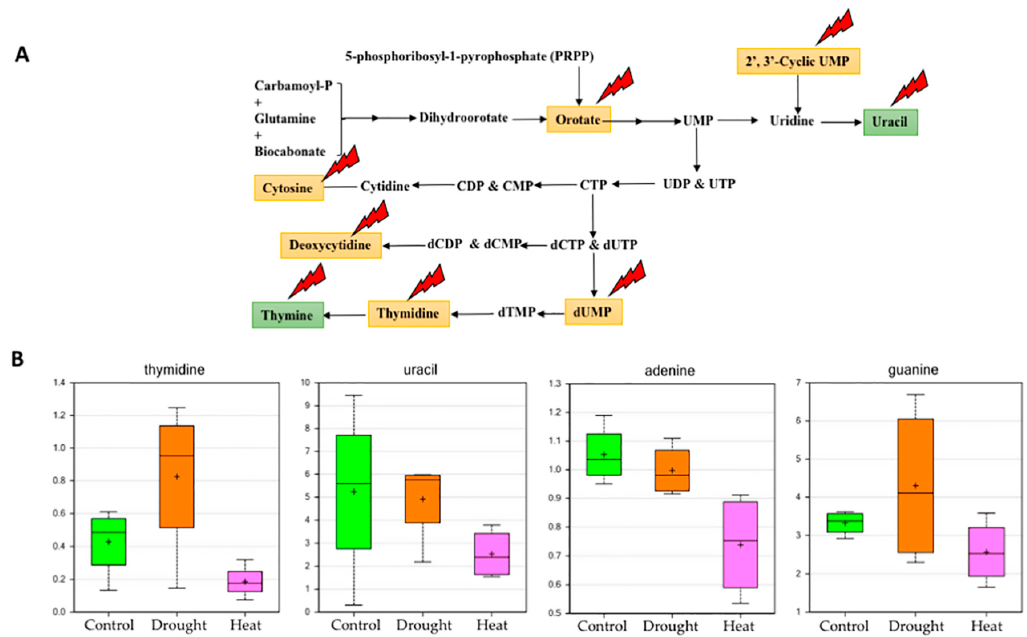
Figure 6. Effect of heat stress on regulation of pyrimidine metabolism. ( A ) Pathway for pyrimidine metabolism showing the metabolites that were found to have a significant effect of stresses on their abundance in the study. ( B ) Box plot showing major purine and pyrimidine bases and their differential abundances under control, drought and heat stress (Box plot description is the same as Figure 2; red lightning sign in ( A ) indicates heat stress).